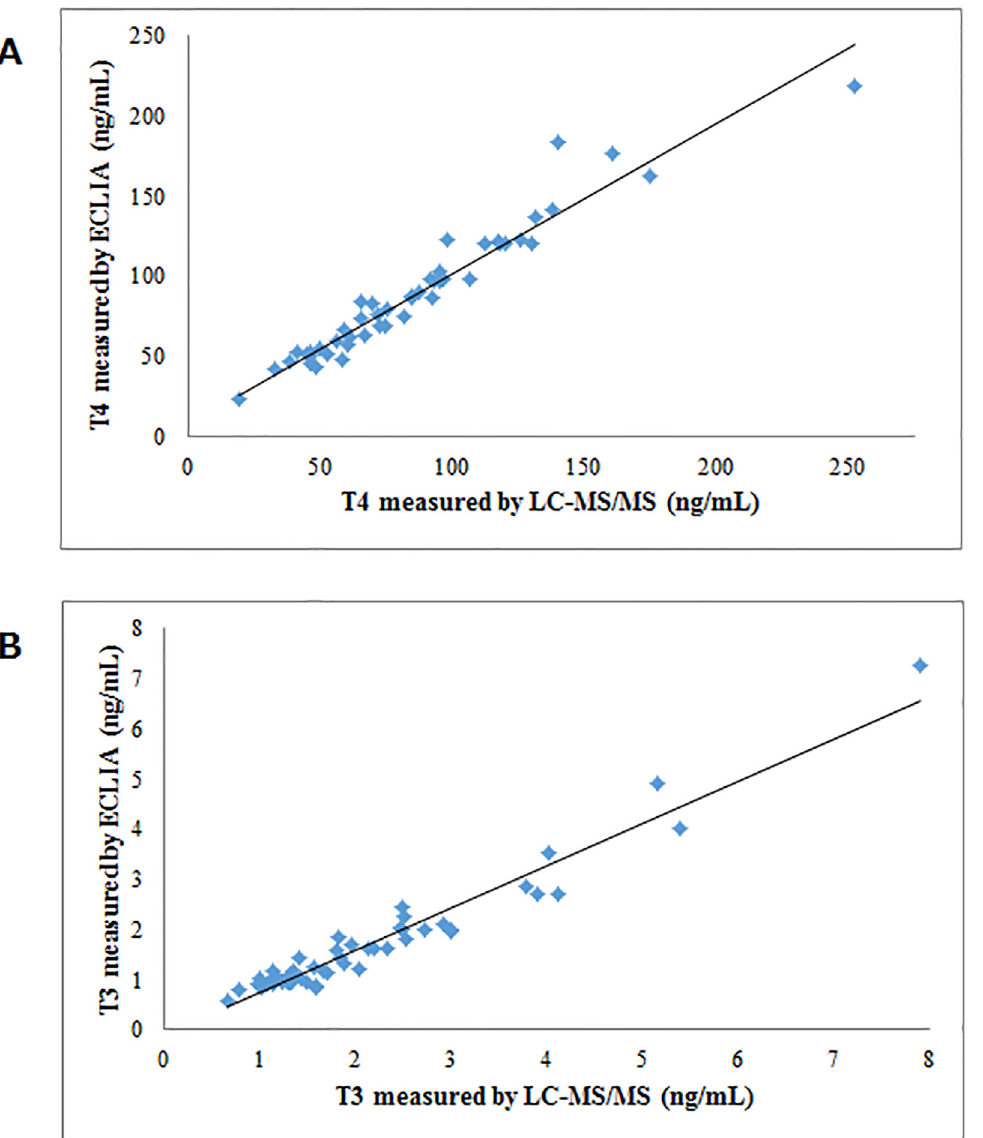
Fig 2. Comparison of the LC/MS/MS method with the ECLIA method for the measurement of serum T4 (A) and T3 (B). (A) y = 0.94x + 8.24, r = 0.976, p < 0.001; (B) y = 0.84x + 0.12, r = 0.912, p <